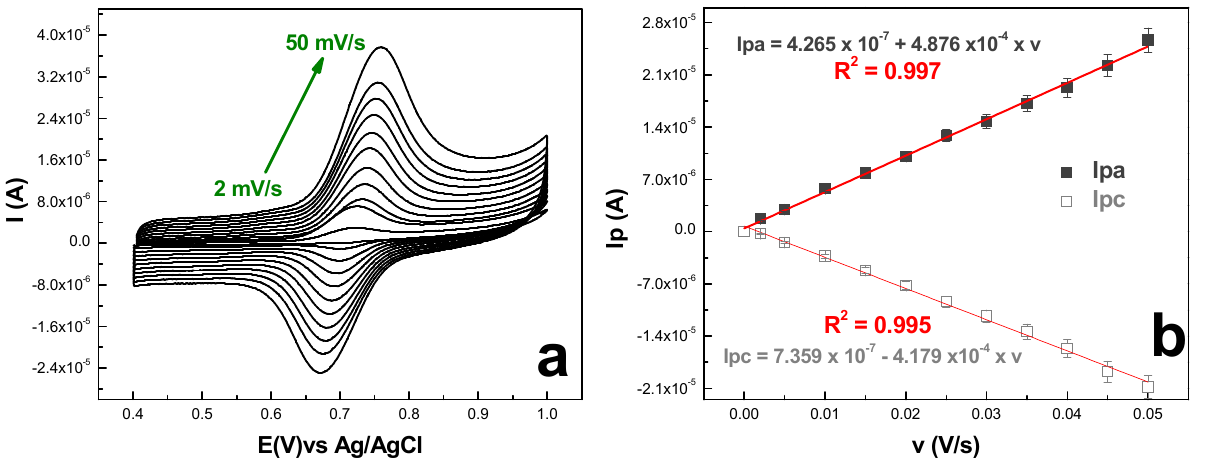
Figure 4. ( a ) CV measurements obtained at GR-exf/GC-modified electrode surface in 100 µM SY at (PBS, pH 6) under various scan rates (2–50 mV/s); ( b ) Intensity of anodic and cathodic peaks versus scan rate.